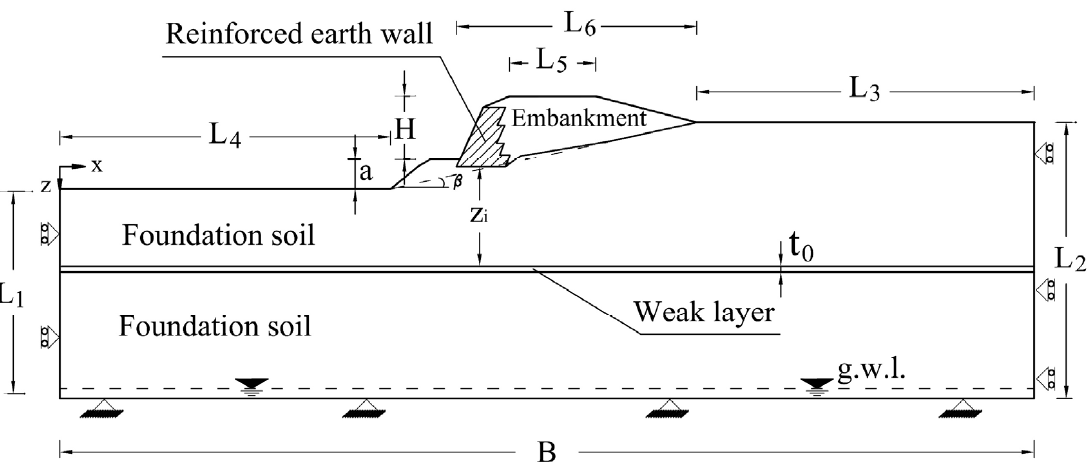
Figure 1. Scheme for formulation of the problem: the weak layer is horizontal and is located at depth z i . Depth z i is measured from the foundation plane of the reinforced earth wall. The boundary conditions and the dimensions of the finite-element (FE) model are also represented in the figure.